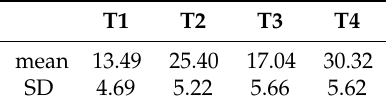
Table 9. Mean and SD of microvessel density (MDV) (CD31).